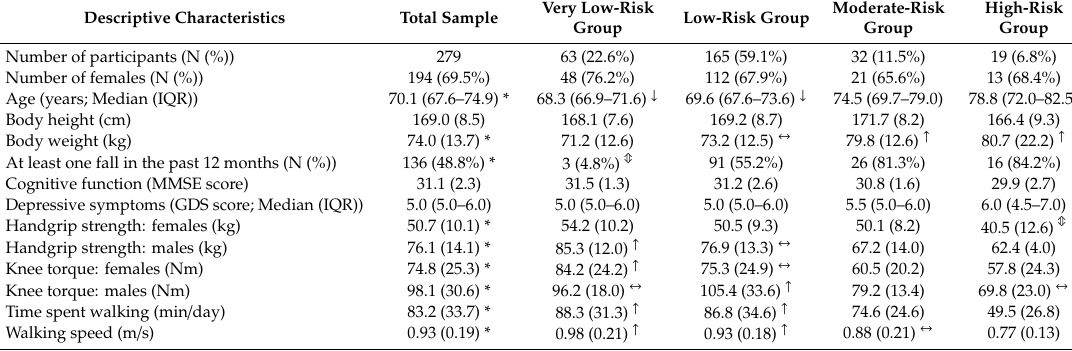
Table 1. Descriptive characteristics of the total sample and per physiological fall risk group as determined by the QuickScreen